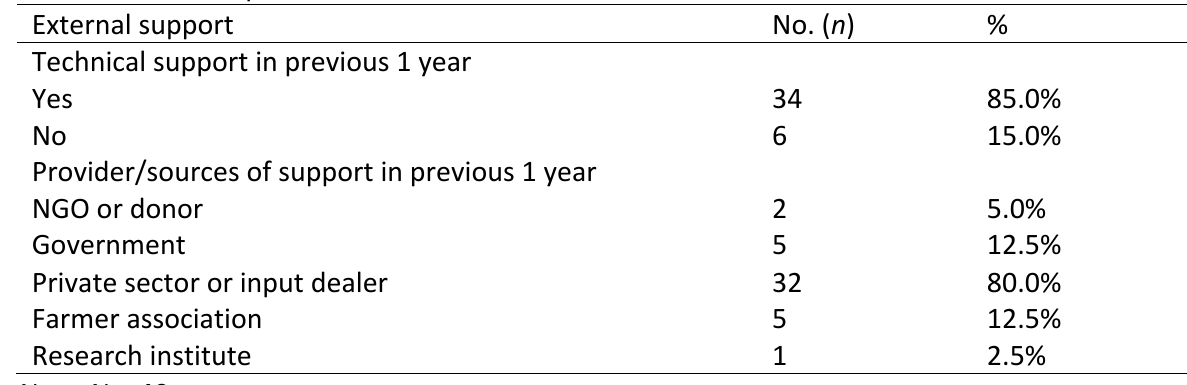
Farmers' Recent Experience with Technical Assistance and